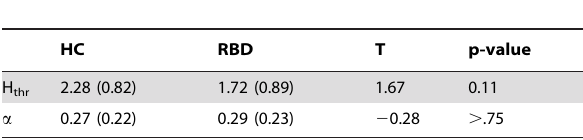
Table 2. The mean (and standard deviation) of each parameter for RBDs vs. HCs.